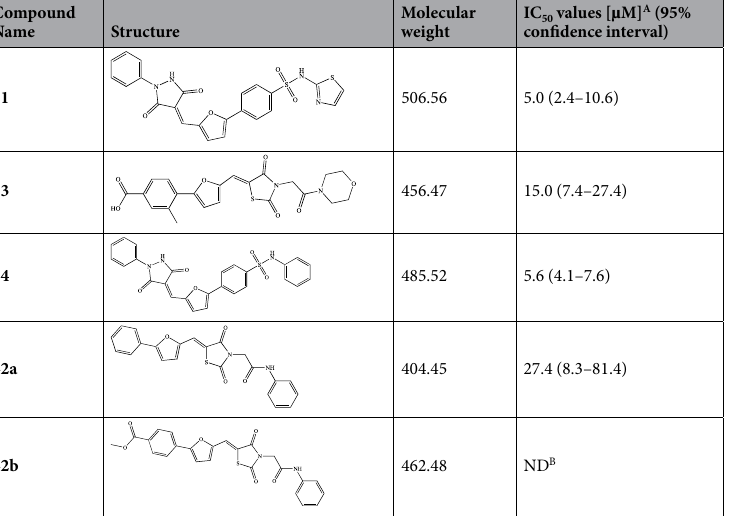
Table 2. IC 50 values of hit compounds against human norovirus Sydney 2012 RdRp activities. A The mean values of triplicate datasets are shown from at least two independent experiments. B Compound too insoluble to attain an accurate IC 50